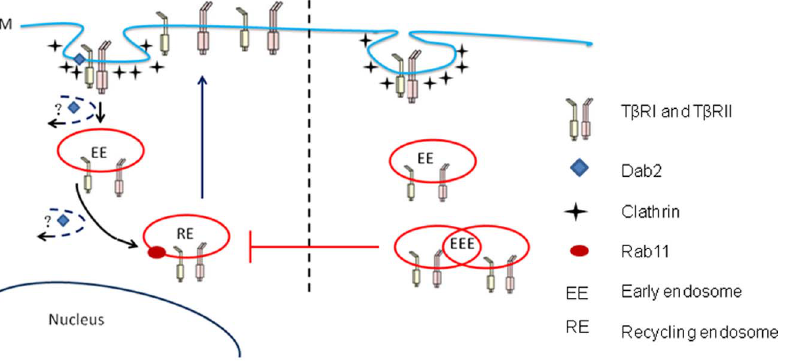
Figure 8. Proposed itinerary of TGF- b receptors in Dab2 absent cells or Dab2 re-expression cells. TGF- b receptors undergoes endocytosis via clathrin-coated pits with involvement Dab2. Receptors enter the early endosomes and return to the cell membrane via Rab11- positive recycling endosomes. Dab2 can promote the transfer of receptors from early endosomes to recycling endosomes. When Dab2 expression is deficient, the TGF- b receptor may accumulate in the early endosomes after endocytosis, leading to the interruption of receptor movement to recycling endosomes, which hinders the return of receptors to cell membranes.